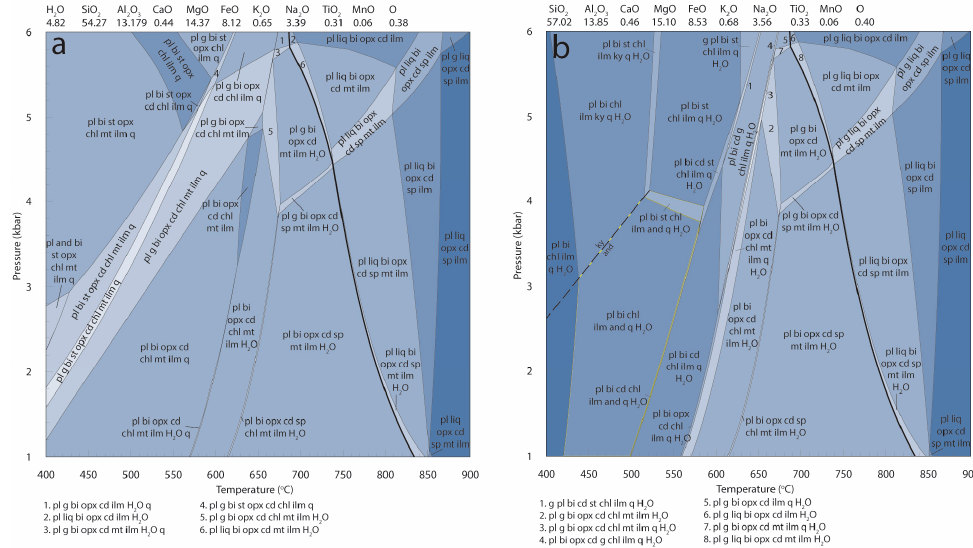
Figure 6. Calculated P–T pseudosections after the second melt reintegration (12% melt reintegrated). The bulk composition (in mol%) was calculated with the addition of a further 6% melt into the composition after the first melt reintegration (Figure 4a) and is given above each pseudosection. The bold black line represents the solidus. ( a ) H 2 O was not set to excess below the solidus, instead subsolidus equilibria were calculated using the H 2 O content of the melt reintegrated composition. ( b ) H 2 O was set to excess below the solidus. Setting H 2 O to excess allows calculation of equilibria with a free water phase at subsolidus temperatures and results in significant changes to the stability of